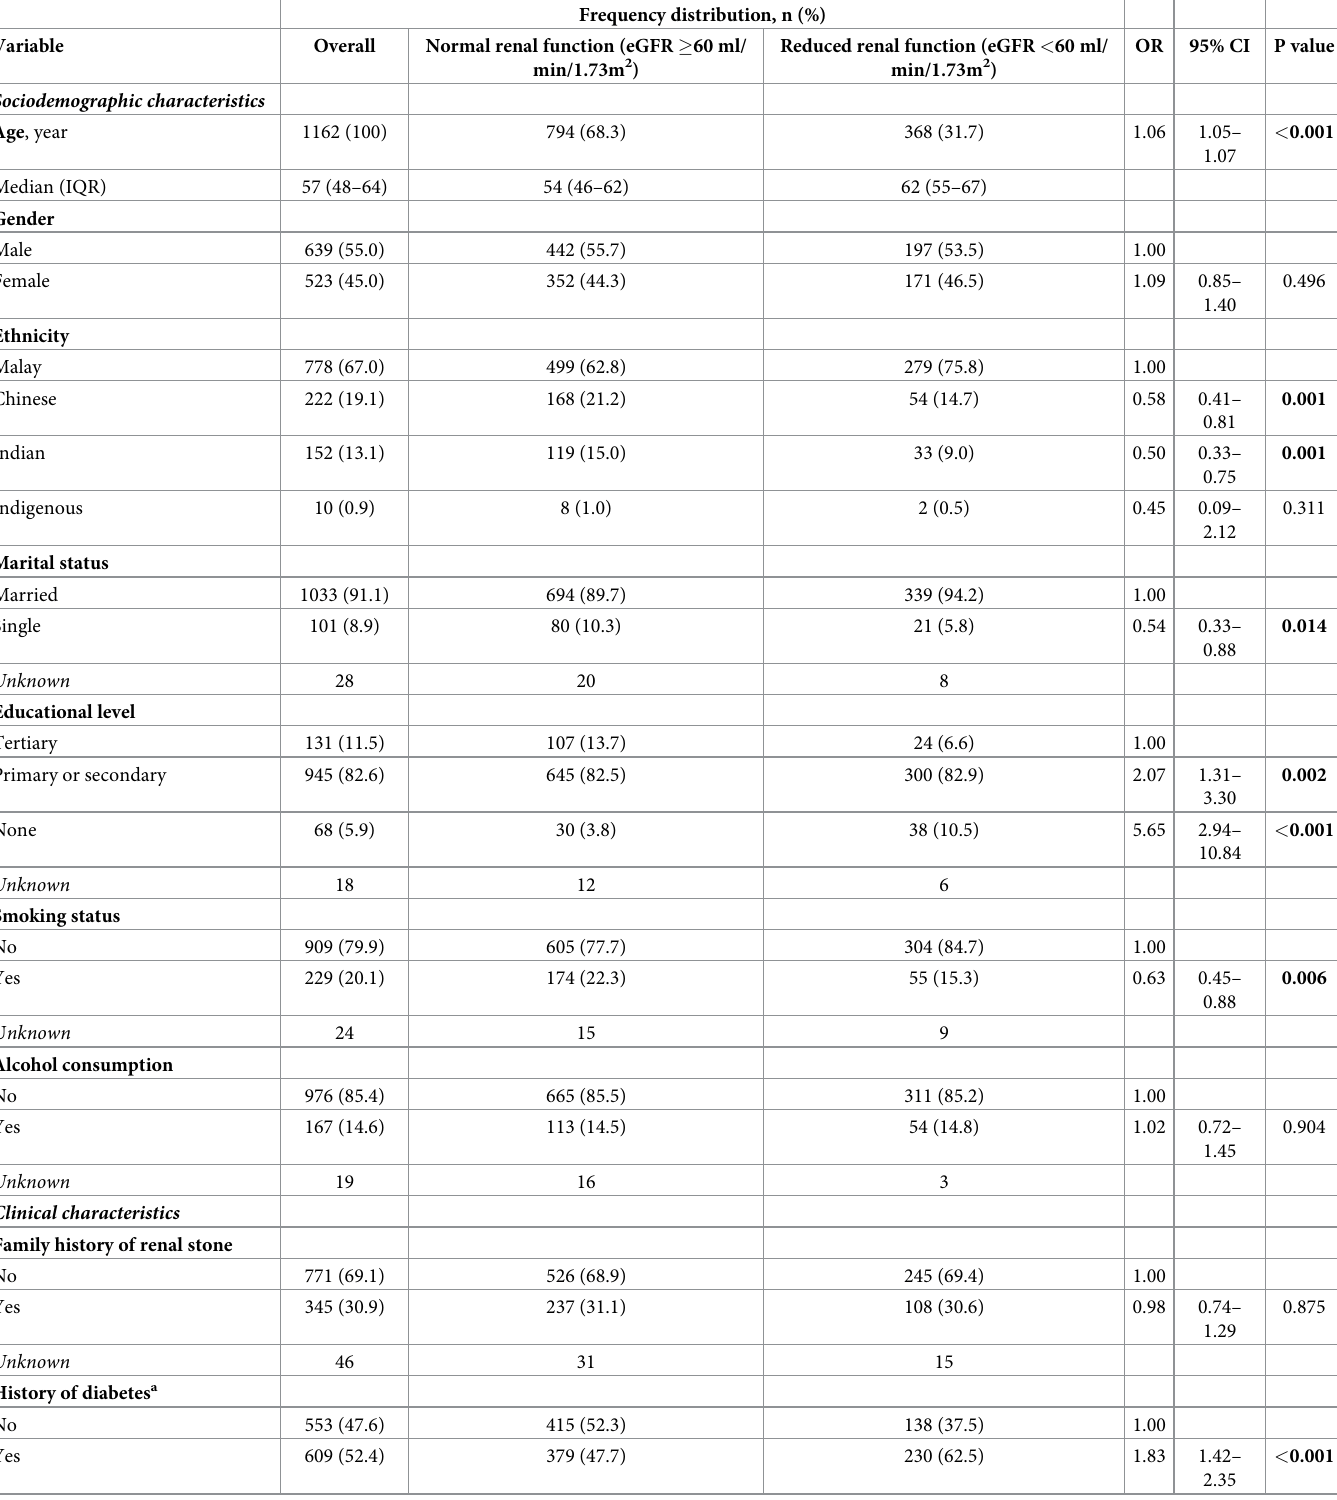
Table 2. Comparison of factors associated with renal function defined by